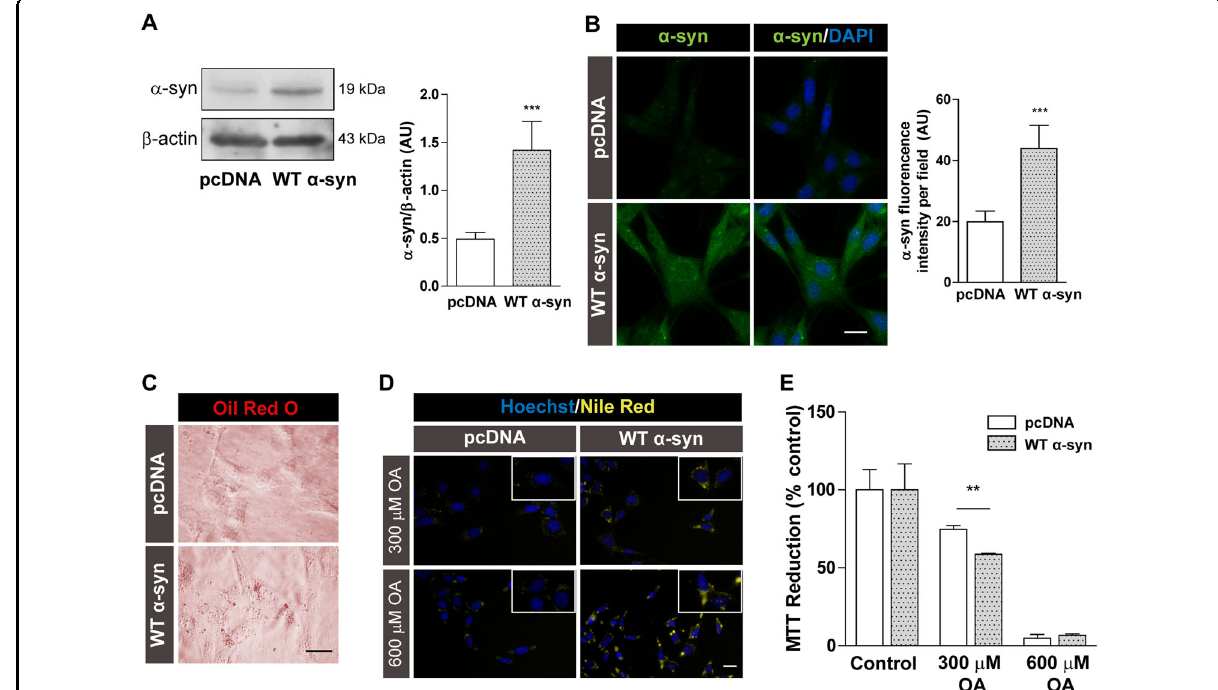
Fig. 1 α -syn overexpression promotes LD accumulation. A , B α -syn expression levels in IMR-32 neuroblastoma cells stably transfected with the empty vector (pcDNA) or the α -syn plasmid expressing human wild type α -syn (WT α -syn) using Western blot and immunocytochemistry studies. DAPI was used as nuclear marker. C Microscopic visualization of LDs through Oil Red O staining in the neuronal model of α -syn overexpression. D Nile Red staining showing an increase in the amount and size of LDs in cells overexpressing α -syn treated with 300 – 600 µM OA, compared to control cells. Hoechst was used as nuclear marker. E Effect on cell viability after 300 – 600 µM OA treatment. A – E Scale bars 20 µm. All experiments were repeated three times. Bars represent means ± standard deviation (SD, n = 3). ** p < 0.01, *** p < 0.001 with respect to the control